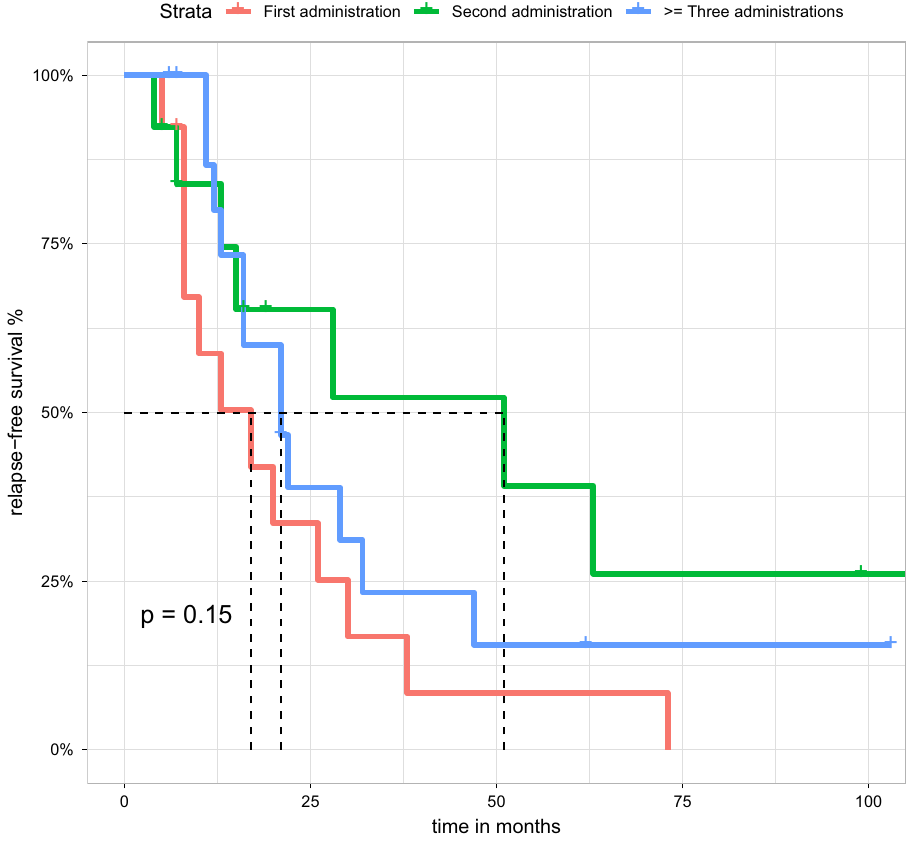
Figure 3. Kaplan Meier estimate showing the relapse-free survival of MCD/FSGS patients treated with RTX. There was no difference in relapse-free survival between first, second or third/subsequent courses ( p =